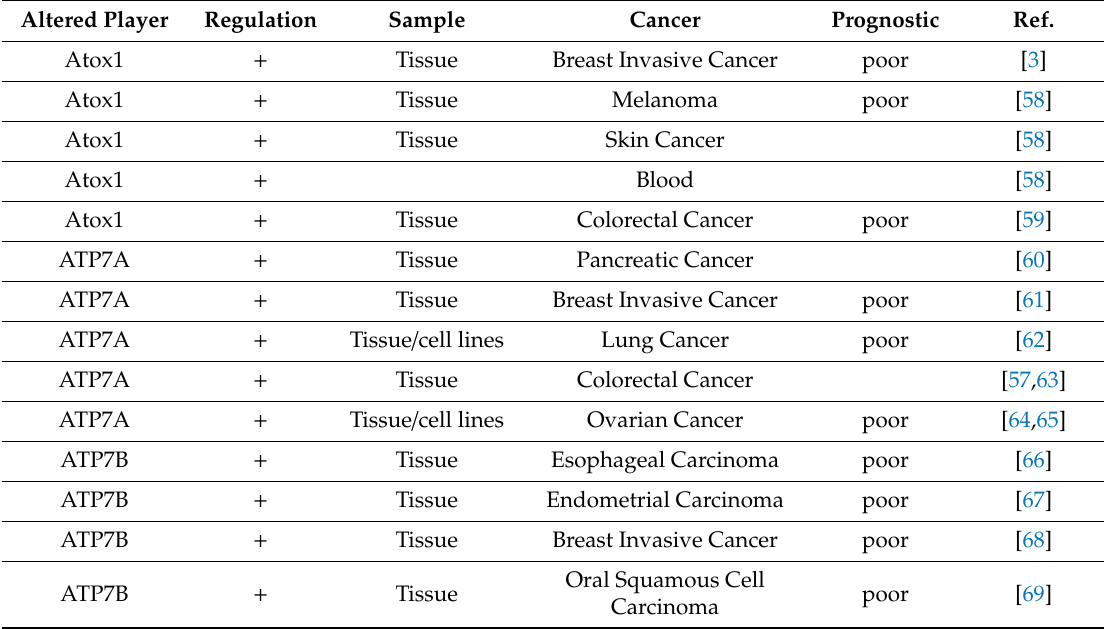
Table 2. Cu proteins a ff ected in cancers and their prognostic